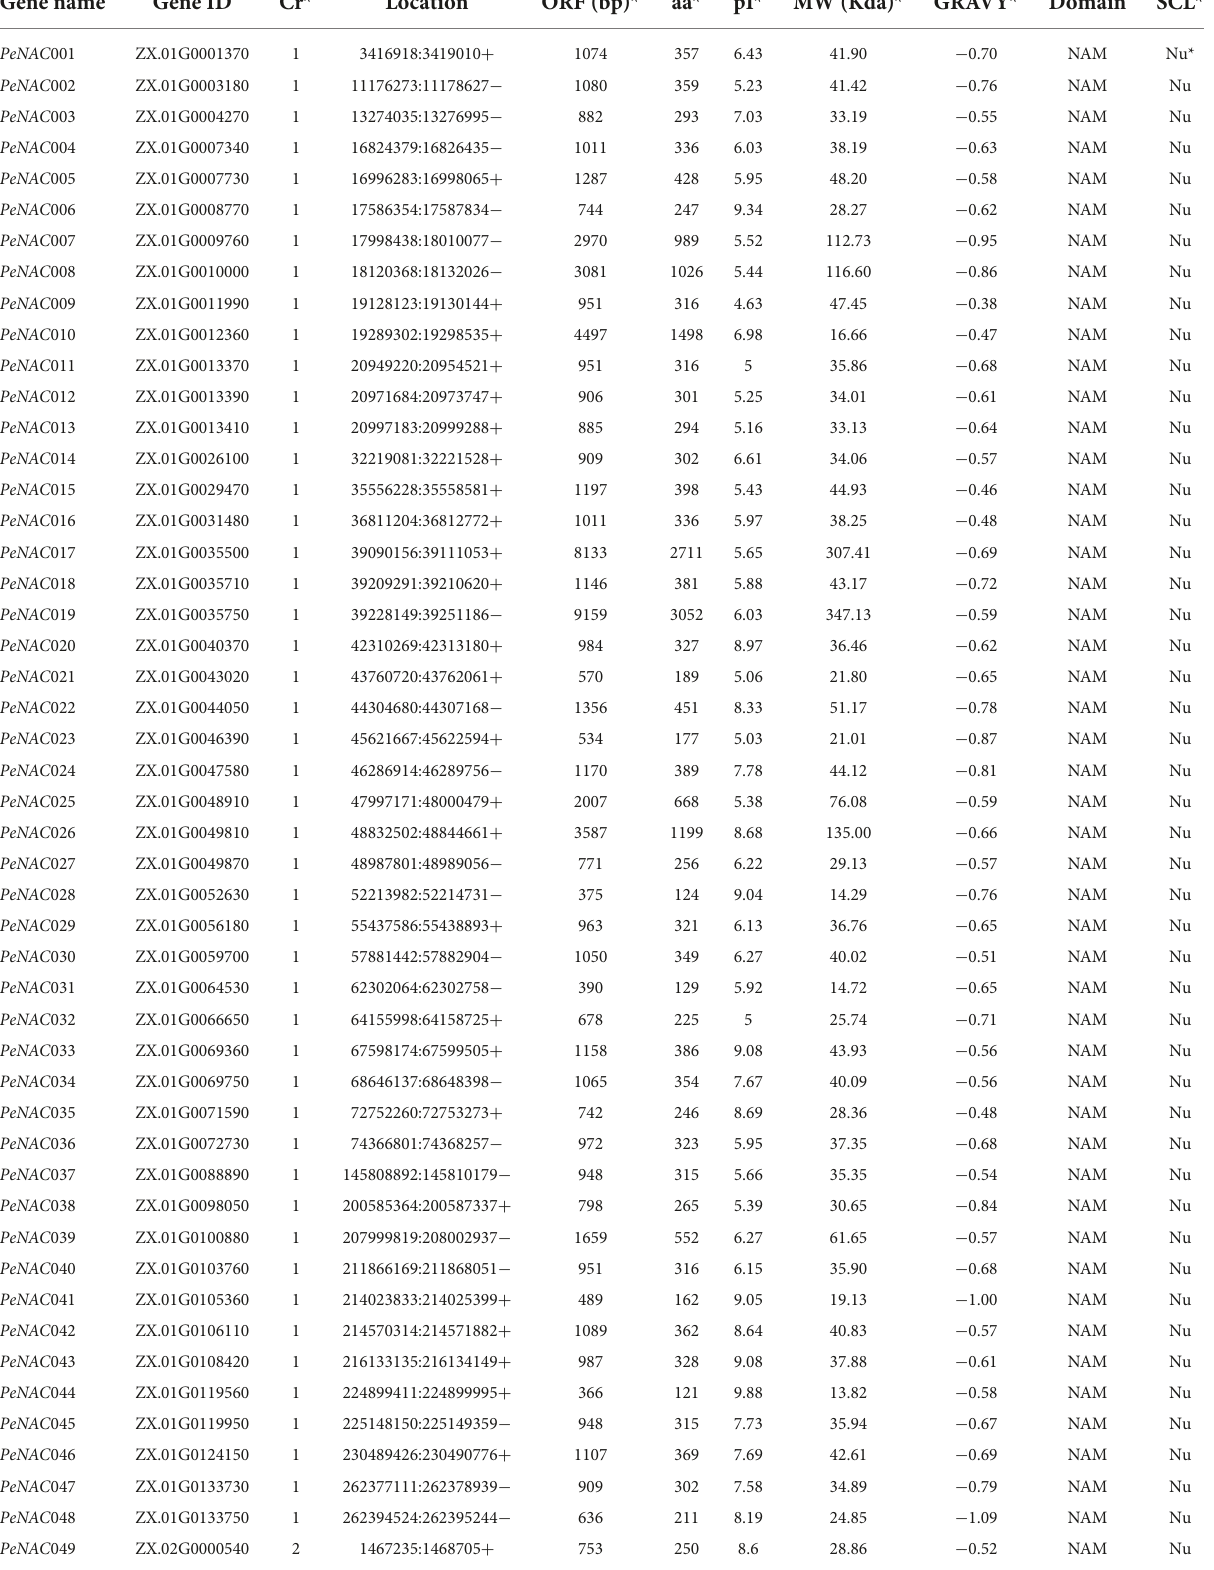
TABLE 1 Physicochemical properties of PeNAC